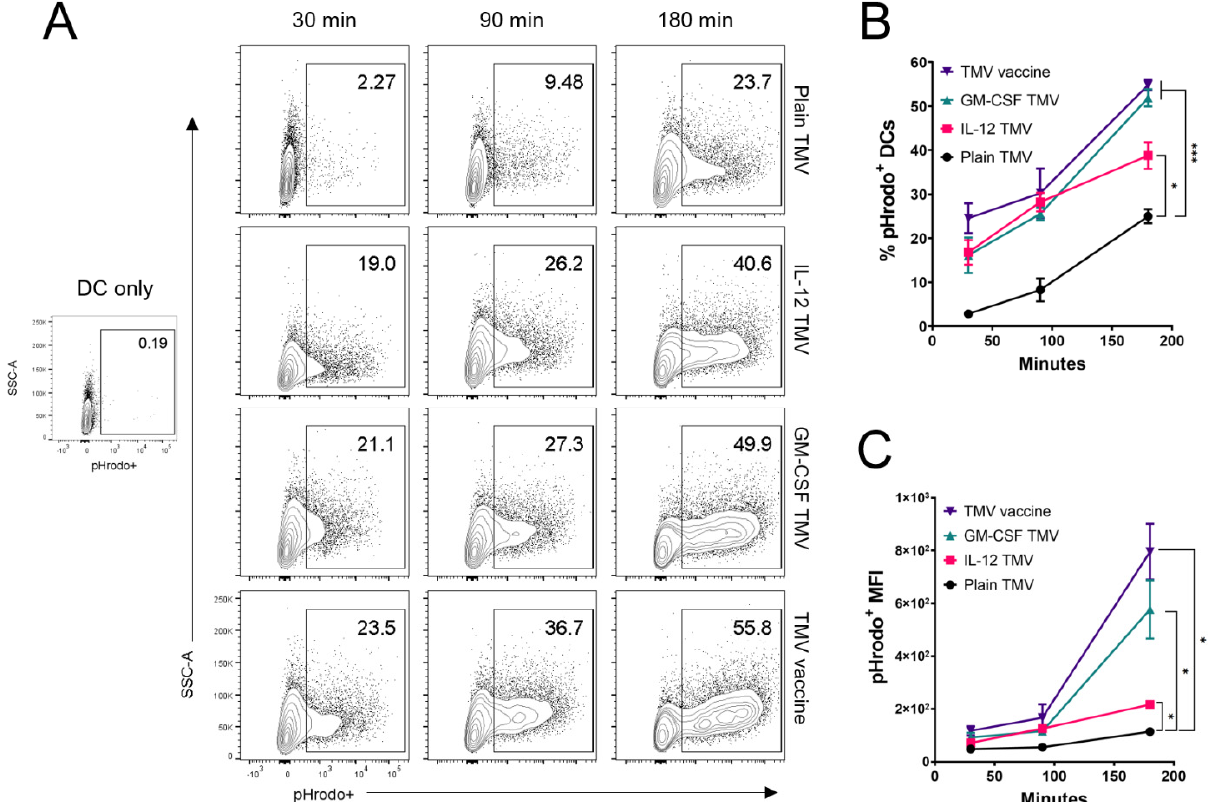
Figure 2. TMV uptake by DCs is potentiated by GPI-ISMs. ( A ), TMVs were labeled with the pH sensitive dye pHrodo Deep Red and incubated with BMDCs for 30, 90 or 180 min, representative contour plots of BMDCs after treatment. ( B ), BMDCs were analyzed by flow cytometry to quantify the percentage of cells that had taken up TMVs into the acidic endolyzosome which activates fluorescence of pHrodo labeled TMVs ( n = 3). ( C ), measurement of the pHrodo MFI of the BMDCs that had taken up TMVs ( n = 3). p < 0.05 *, p < 0.001 ***. Analysis done in ( B , C ) with two-way ANOVA with Tukey’s test for multiple comparisons, error bars represent SD.